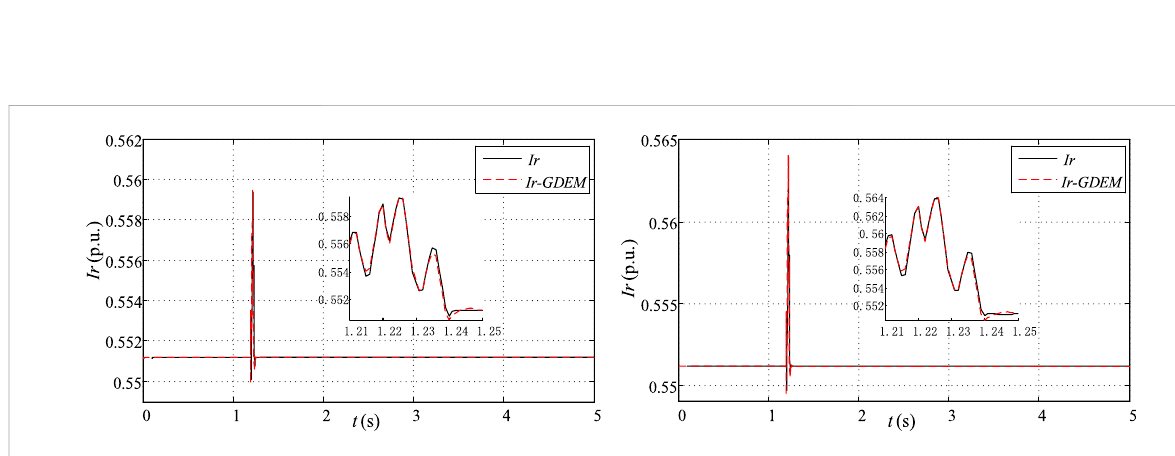
array parameters are shown in Table 1, the initial light intensity of the PV power station is 1,000, and the temperature is 25 ° C.